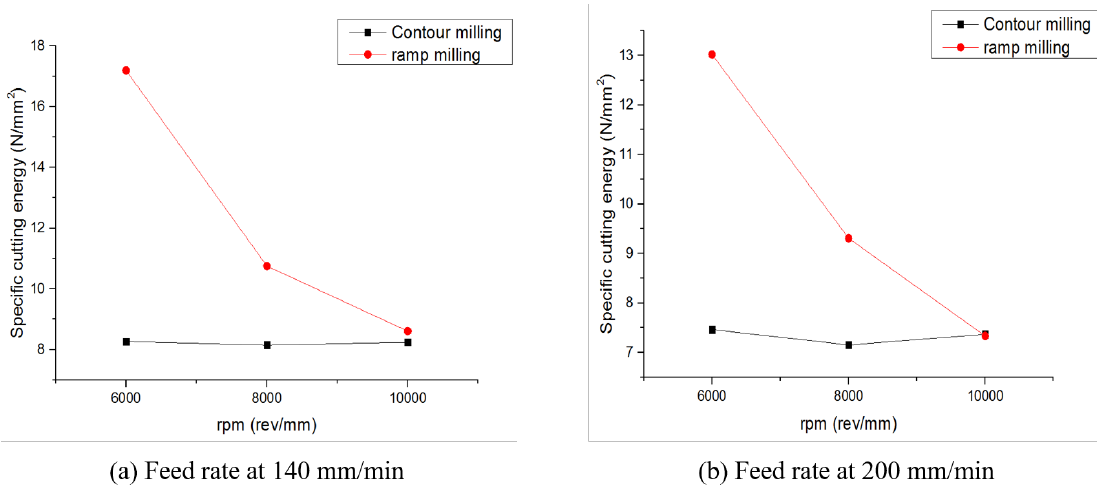
Figure 17. Specific cutting energy of feed rate at 140 mm/min ( a ) and feed rate at 200 mm/min ( b ) with